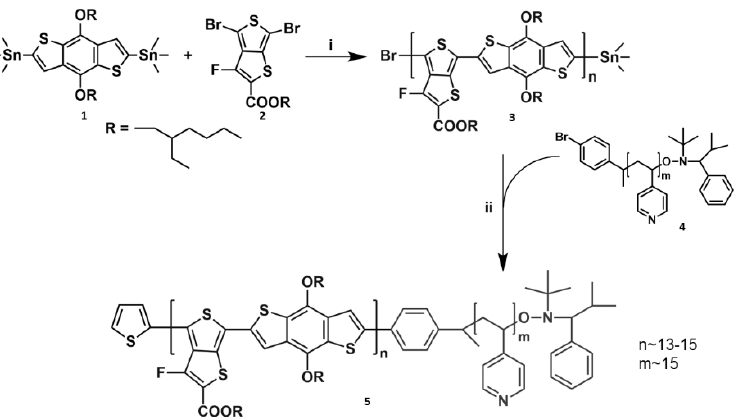
Scheme 1. Synthetic route for the macromer PTB7 (3) and the rod–coil block copolymer PTB7 ‐ b ‐ P4VP (5). Reaction conditions: ( i ) Pd 2 (dba) 3 , P( o ‐ tol) 3 , 120 °C, 24 h; and ( ii ) Pd 2 (dba) 3 , P( o ‐ tol) 3 , 120 °C, 24 h.